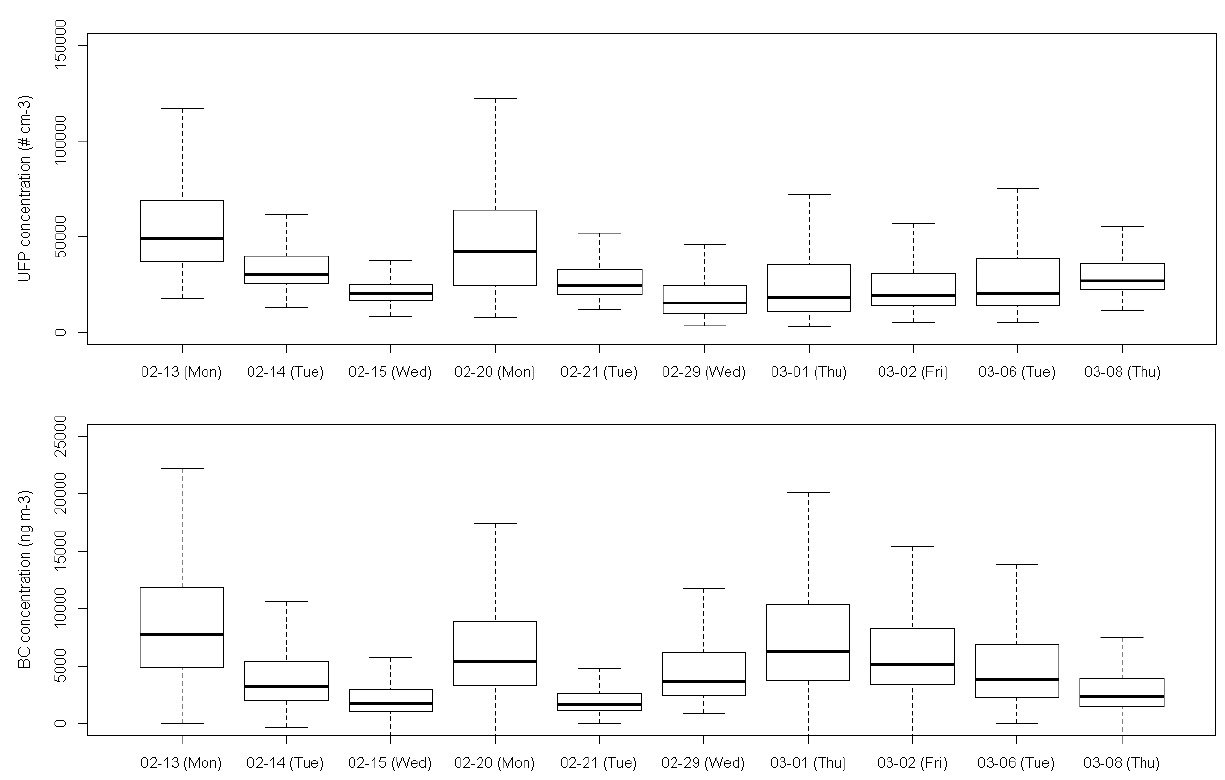
Figure 7. Boxplot of the UFP and BC concentration on the different monitoring days.